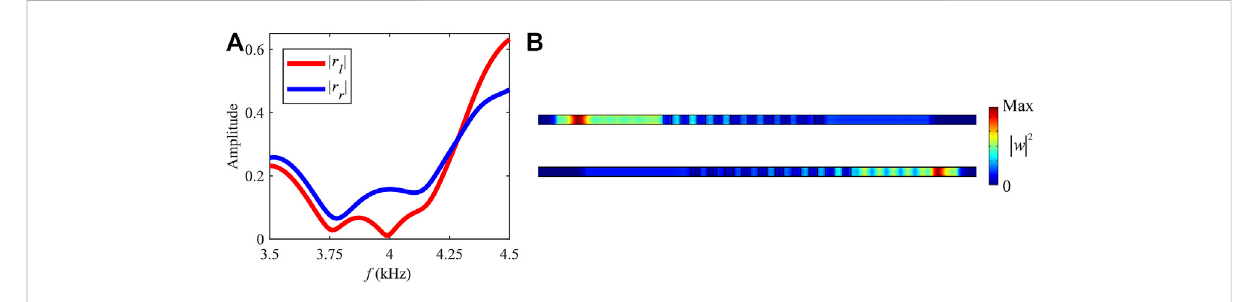
FIGURE 6 (A) Re fl ectioncoef fi cientsofthemetamaterialwithoptimizedparameters. (B) Wave fi eldsfortheincident fl exuralwaveswiththefrequency f from the left and right